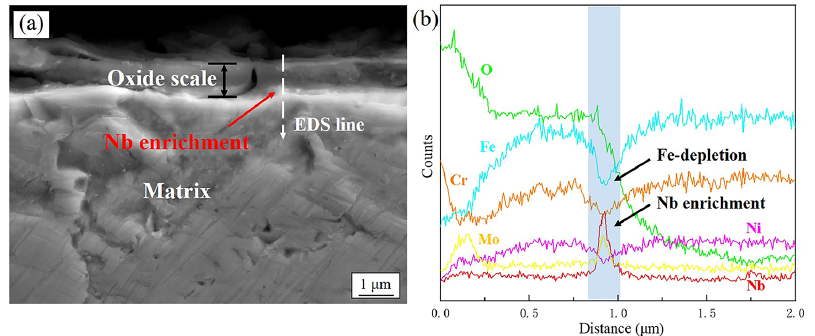
Figure 5. Cross-sectional SEM ( a ) with the corresponding EDS line profile ( b ) images of sample S1 after exposure to CO 2 at 650 °C under 3.5 MPa for 1000 h.